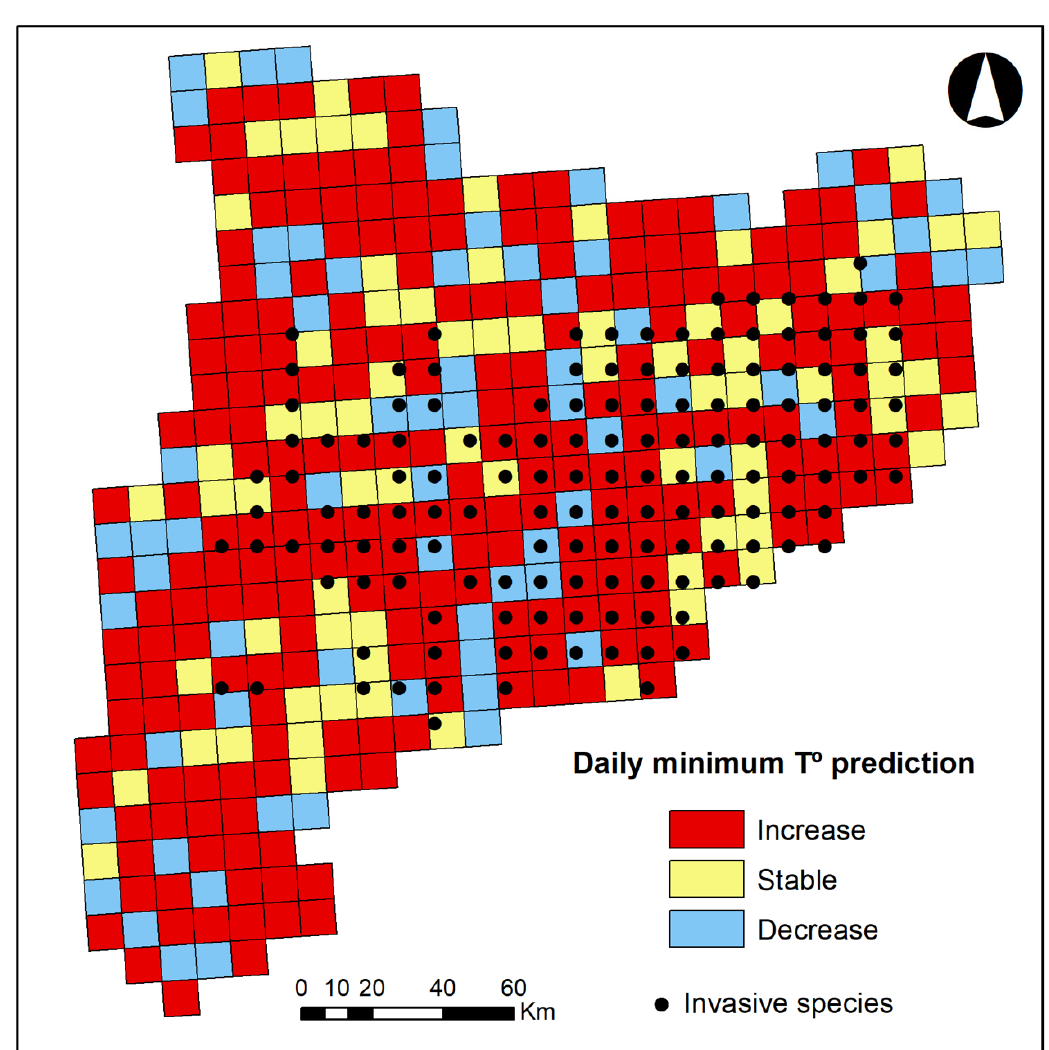
Figure 2. Minimum temperature prediction and invasive species distribution.